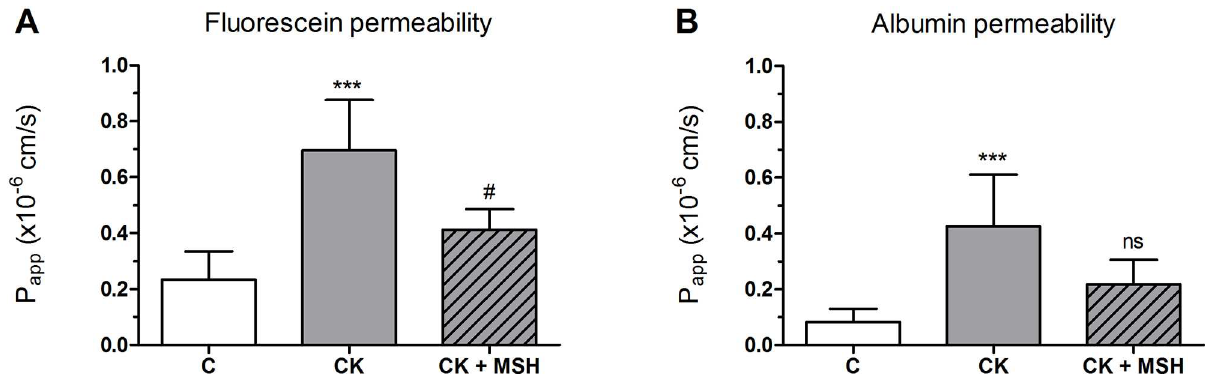
Fig 3. The effect of α -MSH treatment on the permeability of cytokine treated Caco-2 monolayers. Caco-2 monolayers grown on culture inserts were treated with cytokines (CK; 50 ng/ml TNF- α and 25 ng/ml IL-1 β ) without or with α -MSH (10 − 8 M) for 24 hours, then permeabilitywas measuredfor fluorescein (A) and albumin(B). The control group (C) received culture medium. Means ± S.D., n = 4–6; *** P < 0.001, # P < 0.05. P app , apparentpermeability coefficient. * : CK, CK+MSH comparedto C; # : CK+MSH compared to CK, ns: no significantdifference to C or